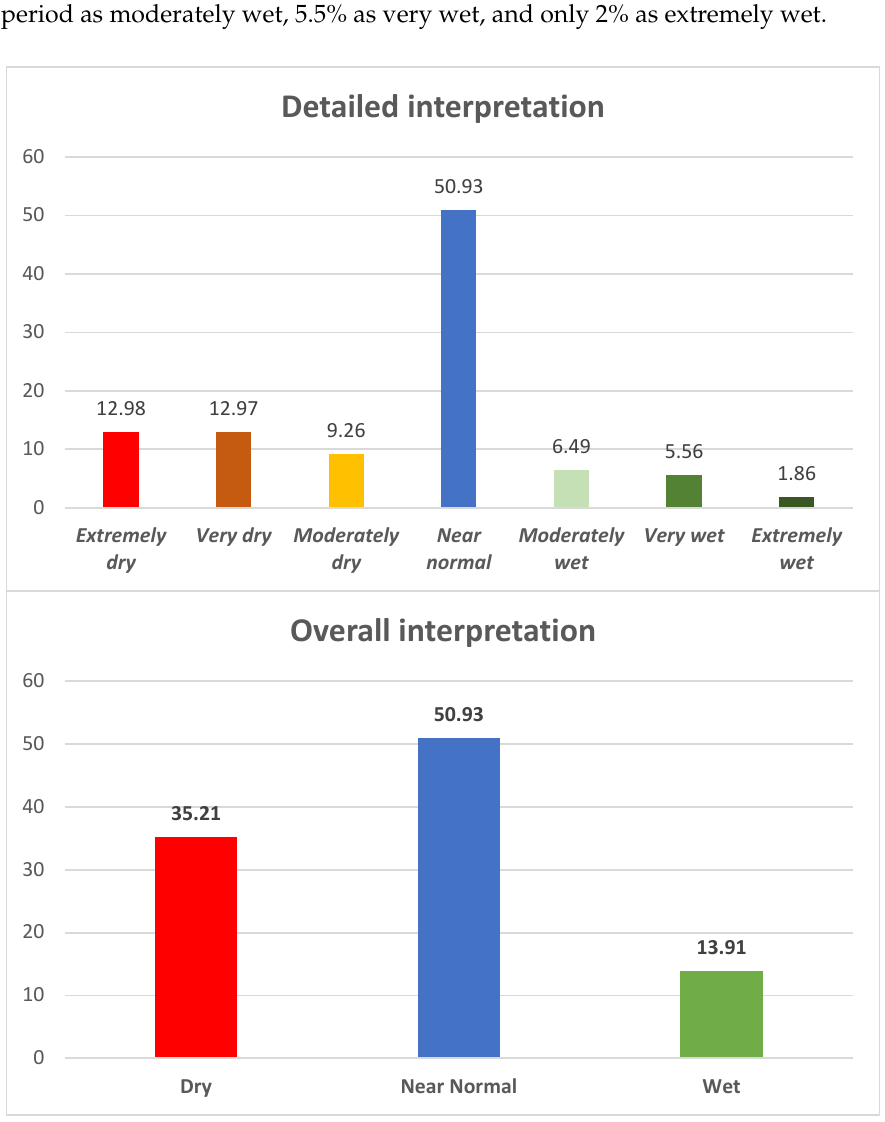
Figure 6. Drought frequency distribution based on monthly forecasted SPI from 2022 to 2030.